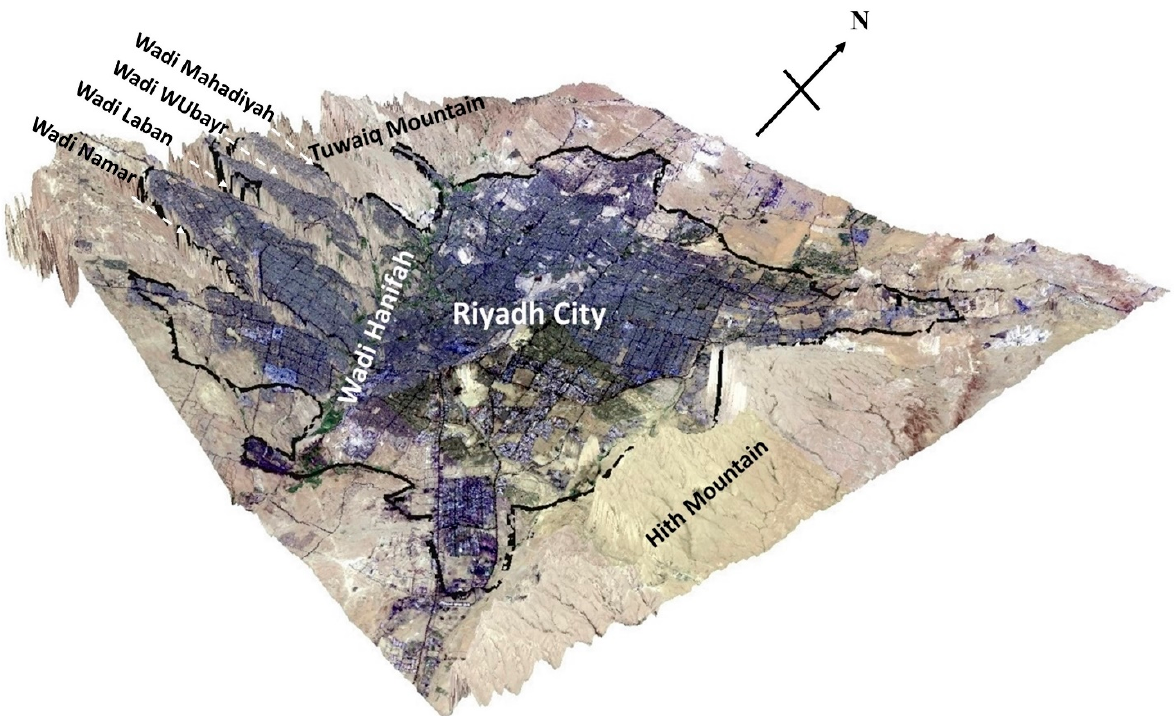
Figure 2. A 3-D rendering of a Landsat 8 false color image (spatial resolution: 30 m) over the study area draped over a DEM (vertical exaggeration: 30) showing the city of Riyadh largely occupying the lowlands in between the Tuwaiq mountains in the west and the Hith Mountains in the east.